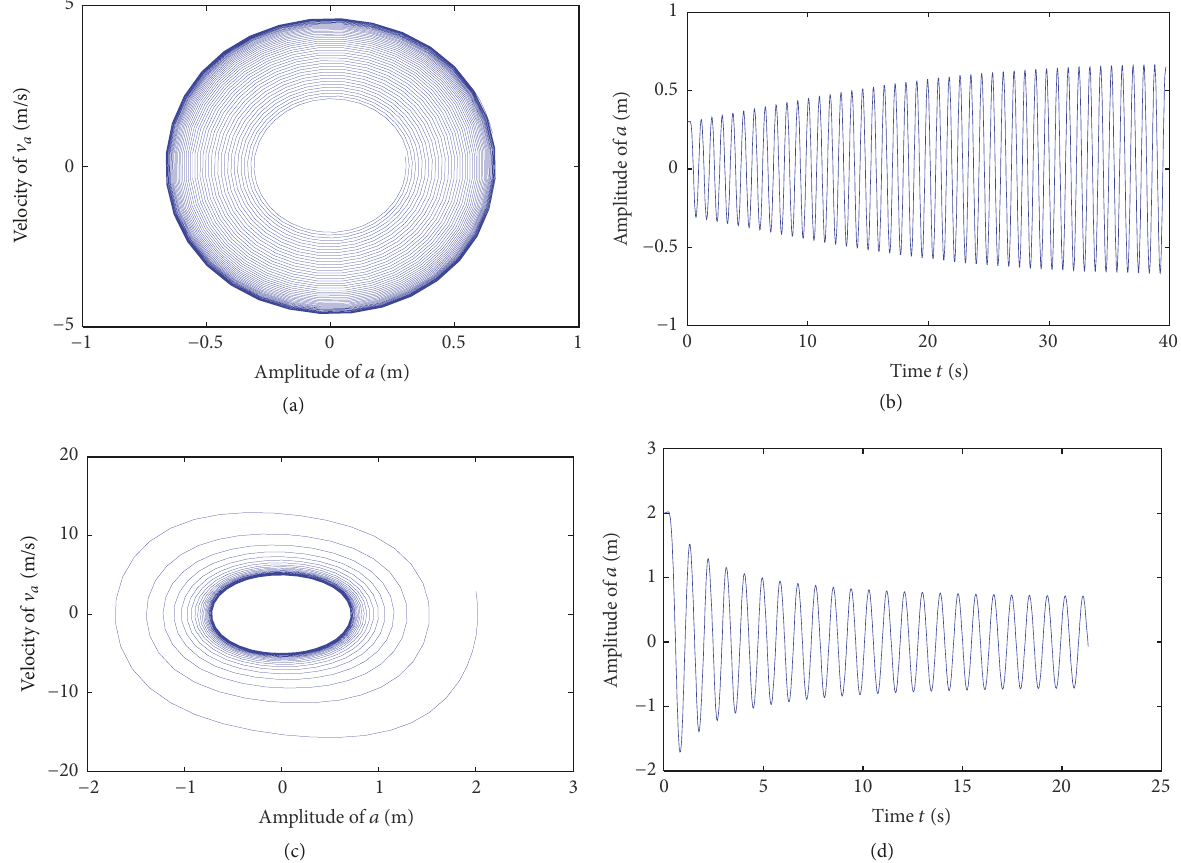
Figure 13: Phase portrait and time-domain vibration amplitude of Hopf